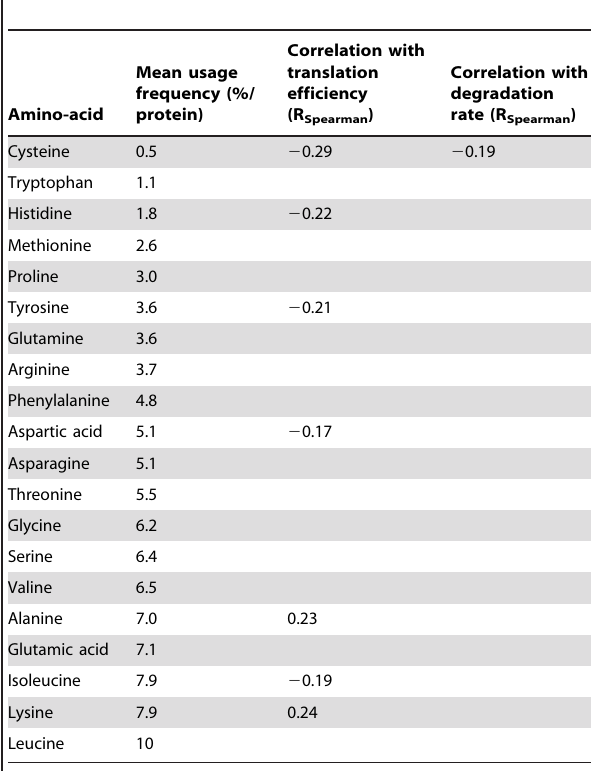
Figure 3. Distribution of translation efficiency and degradation rate constant for different growth rates in L.lactis . Histograms for translation efficiency, k 9 , (A) and protein degradation rate, k 0 , (B) with coloured bars (black for m =0.88 h 2 1 , dark grey for m =0.47 h 2 1 , grey for m =0.24 h 2 1 and white for m =0.09 h 2 1 ) and lines indicating the Gaussian tendency curves.